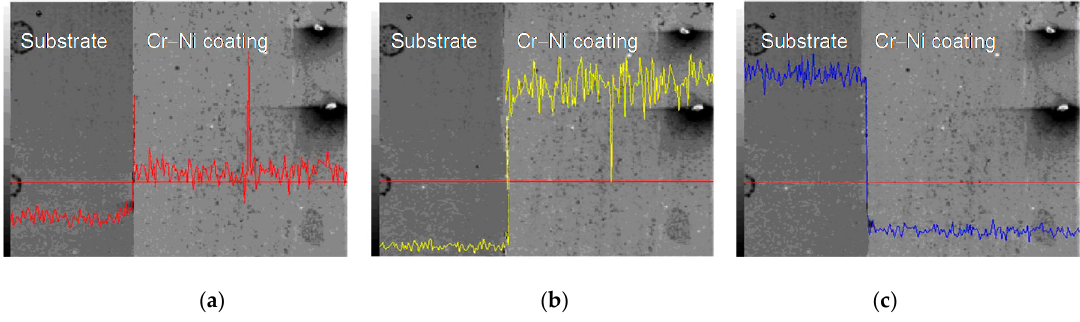
Figure 7. Line scan analysis of 20% Cr–80% Ni coating interface. ( a ) Line scan analysis of Cr content;